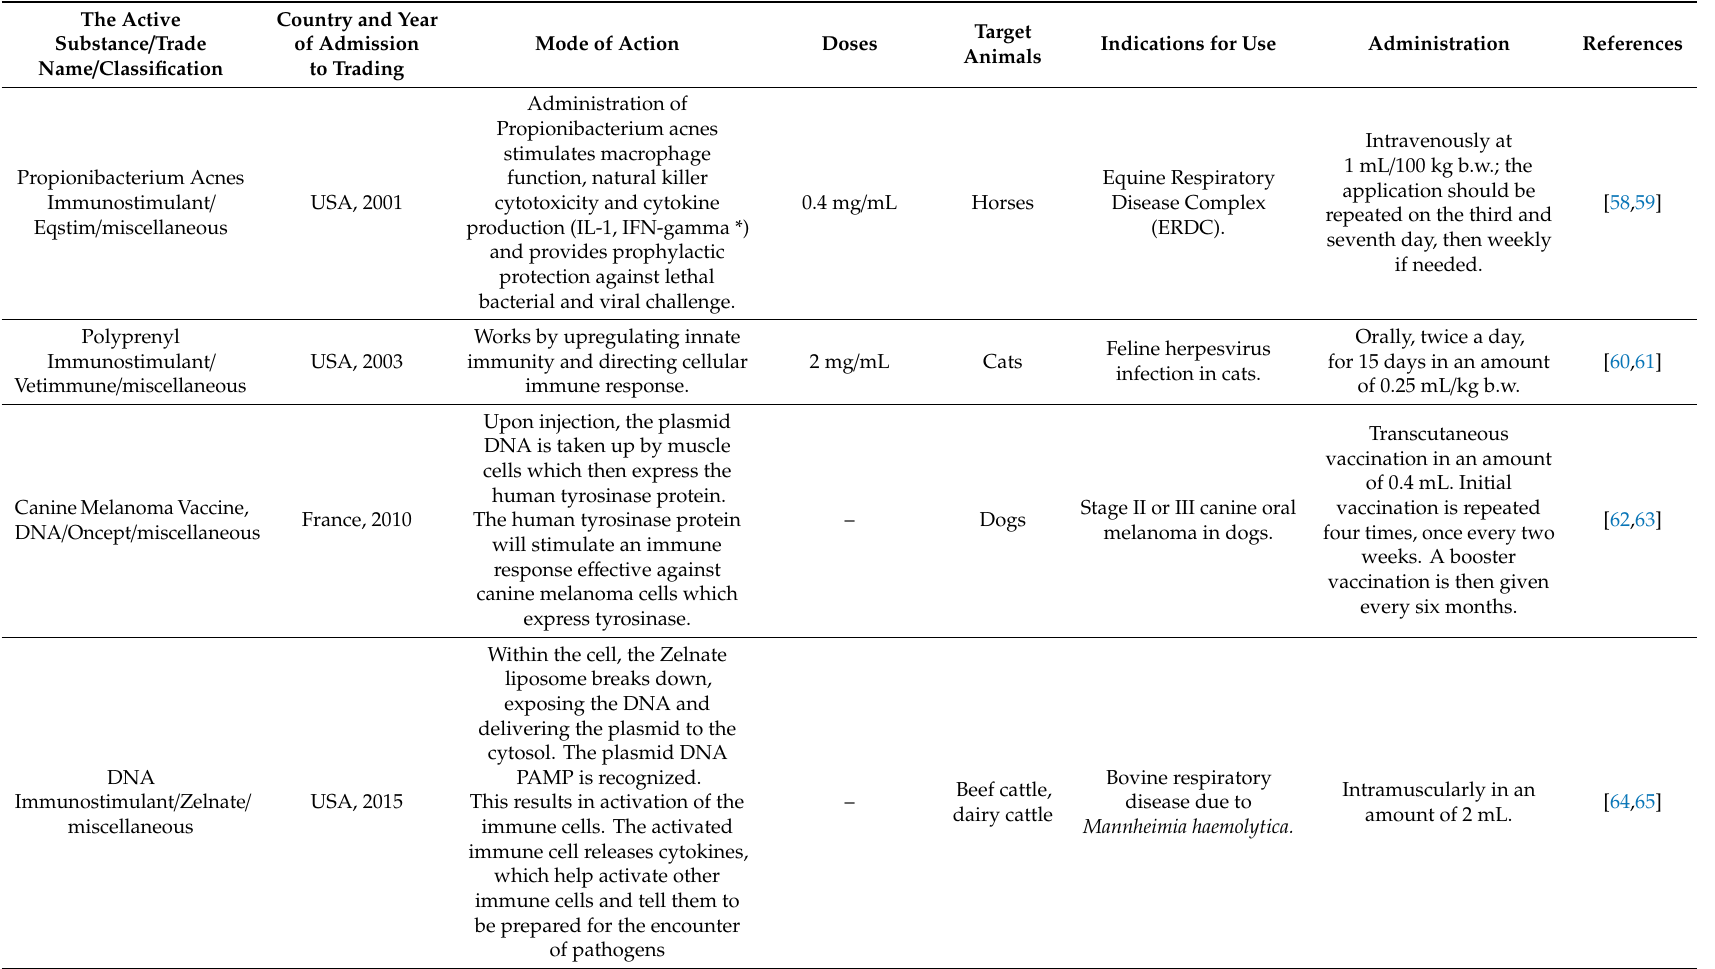
Table 2. Veterinary biological medicinal products approved by United States Department of Agriculture (USDA) for marketing in the United